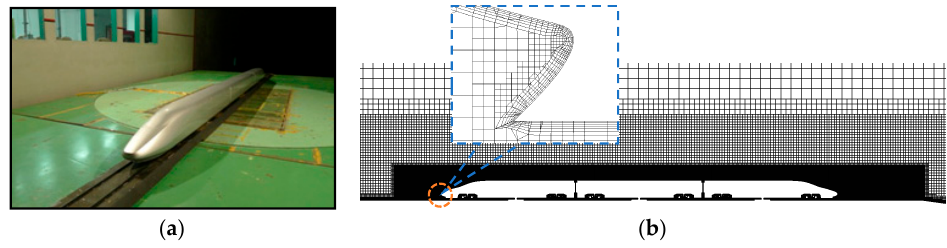
Figure 2. Wind tunnel train model and mesh configuration for numerical simulation: ( a ) wind tunnel model; and ( b ) mesh configuration.